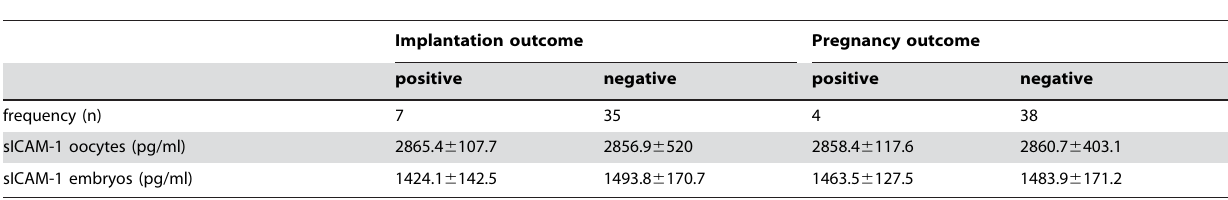
Table 1. sICAM-1 release, implantation outcome and pregnancy outcome.